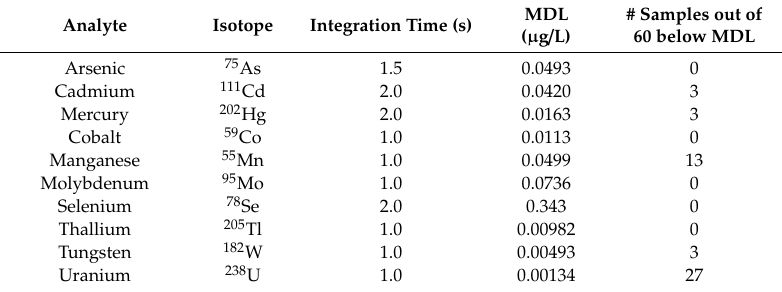
MDL # Samples out of ( µ g / L) 60 below MDL